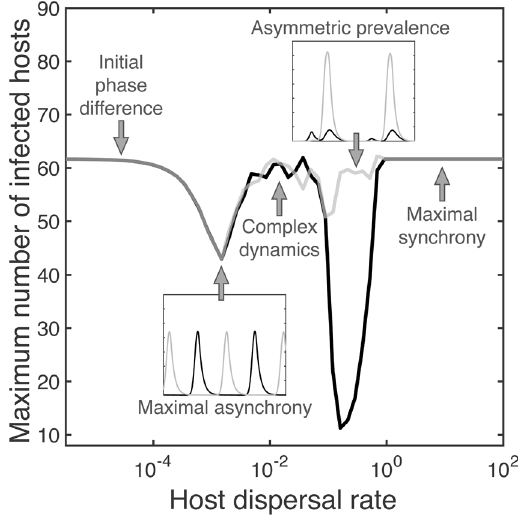
Figure 4. Host dispersal influences the sizes of epidemic outbreaks. Maximum outbreak sizes of two patches are denoted with grey and black curves (averaged over 50 randomly initialized runs, a = 0.55, h = 0.25, κ = 3, λ = 1, ν = 0.01). With very small rates, the two patches are practically independent in their dynamics. The minor movement of infected hosts pushes patches to maximal asynchrony (a lower small panel shows the dynamics of infected host populations) due to better consumer persistance. After the host dispersal range of symmetric complex dynamics, even stronger indirect pathogen flow causes asymmetry in disease prevalence (an upper small panel shows the part of a single run). Finally, the patches become fully synchronised with extremely strong